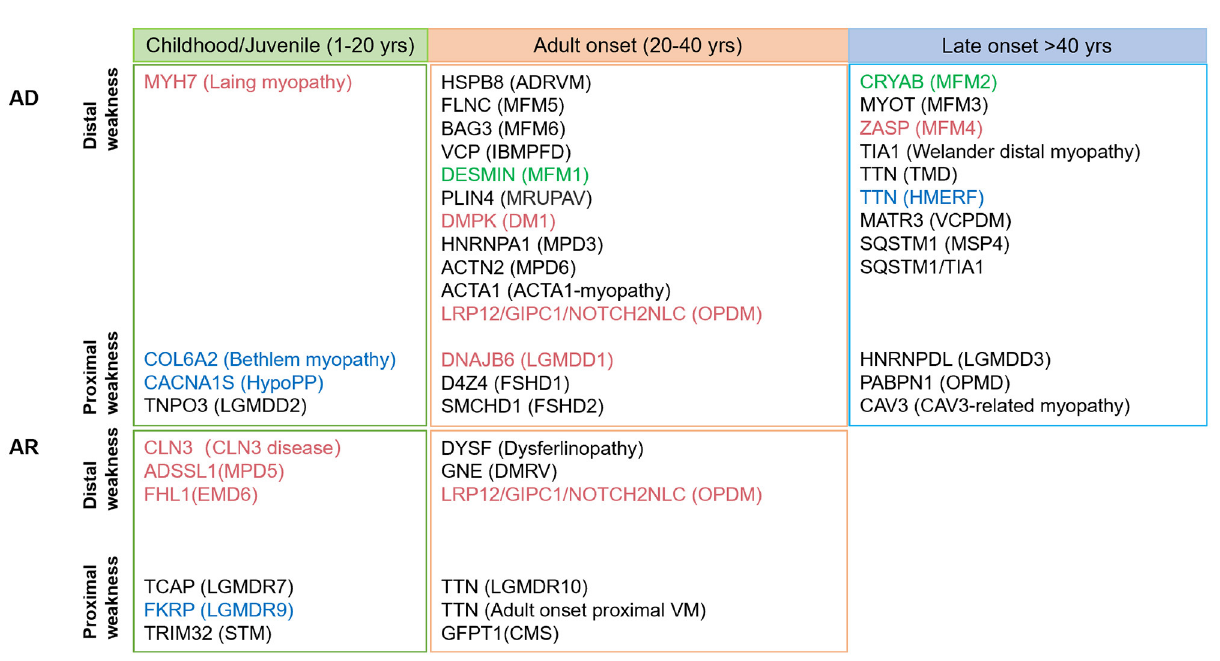
FIGURE2 Schematic diagram of the various age (not drawn to scale) at early- and late-onset subtypes of rimmed vacuolar myopathies described based on the hereditary mode. Mutations associated with cardiomyopathy and respiratory failure are shown in red and blue, respectively; mutation corresponding to both is indicated in